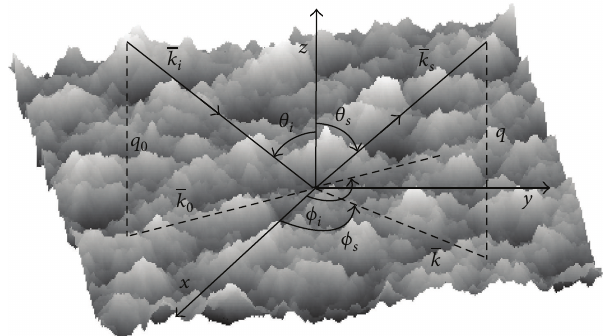
Figure 2: Geometry of 2D sea surface scattering problem.